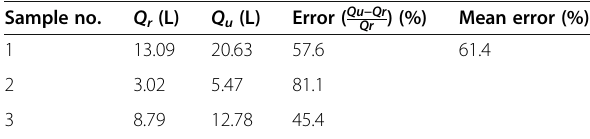
Table 2 Estimates of error in calculating daily whole-tree water use when assuming uniform sap flux density Sample